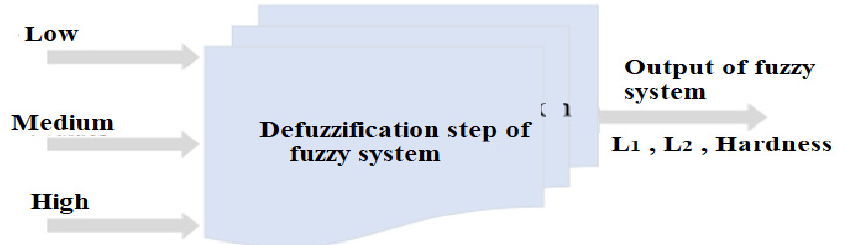
Figure 10. Defuzzification process in fuzzy system.